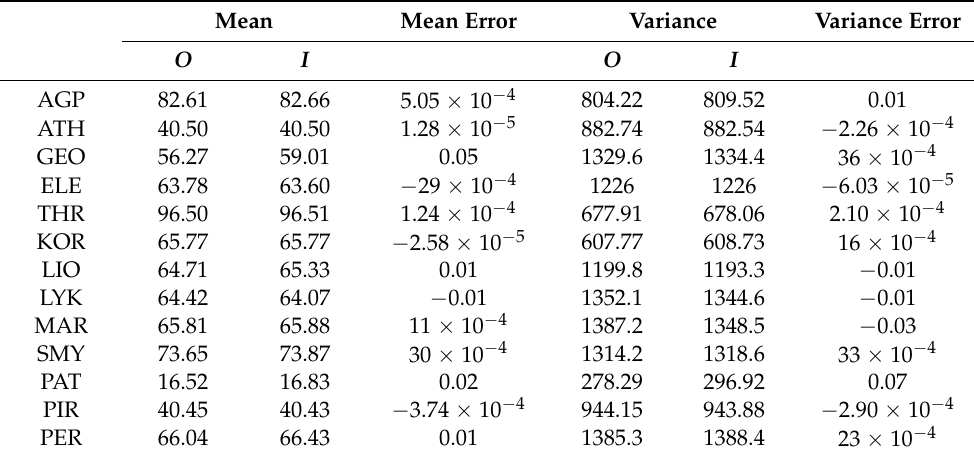
Table 6. Mean and variance values results, for the original ( O ) and the interpolated ( I ) datasets, along with the corresponding error, per monitoring station for O 3